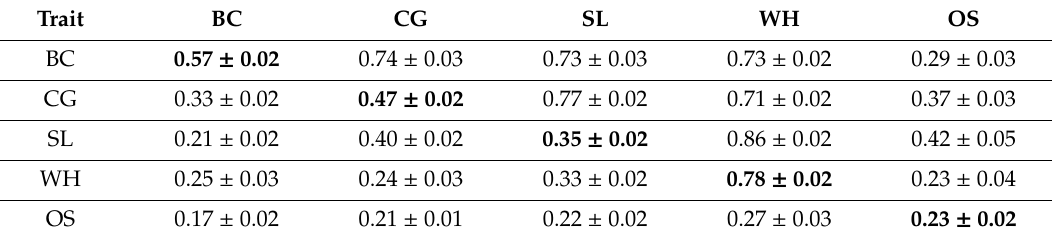
Table 2. Estimates of heritability ± s.e. (diagonal), genetic (above diagonal) and environmental (below diagonal) correlation ± s.e. of the final five traits model.